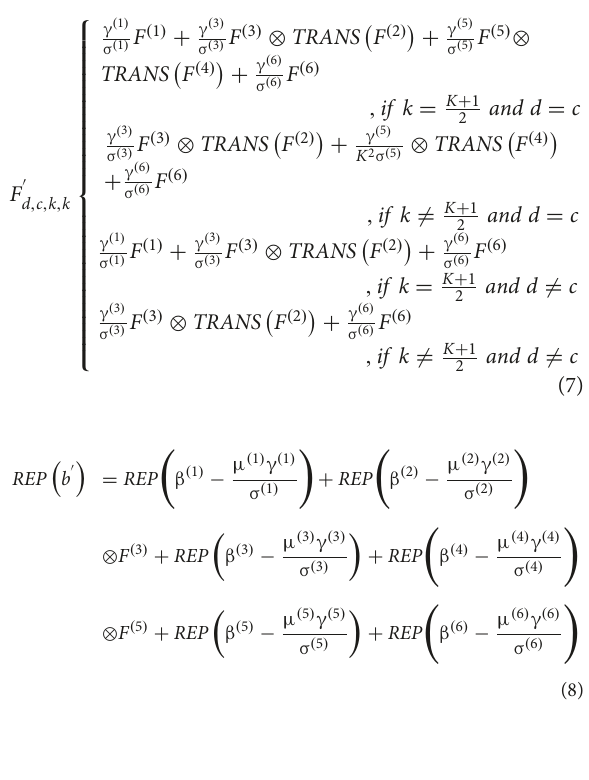
channels and K × K is the size of the convolution kernel. The output of the convolution kernel is O ∈ R D × H is the size of the output feature map, which is determined by the settings of K , padding, and stride. We use ⊗ to denote the convolution operator and formulate the bias addition by replicating the bias b into REP ( b ) ∈ R D × H to the results of the convolution. According to the homogeneity